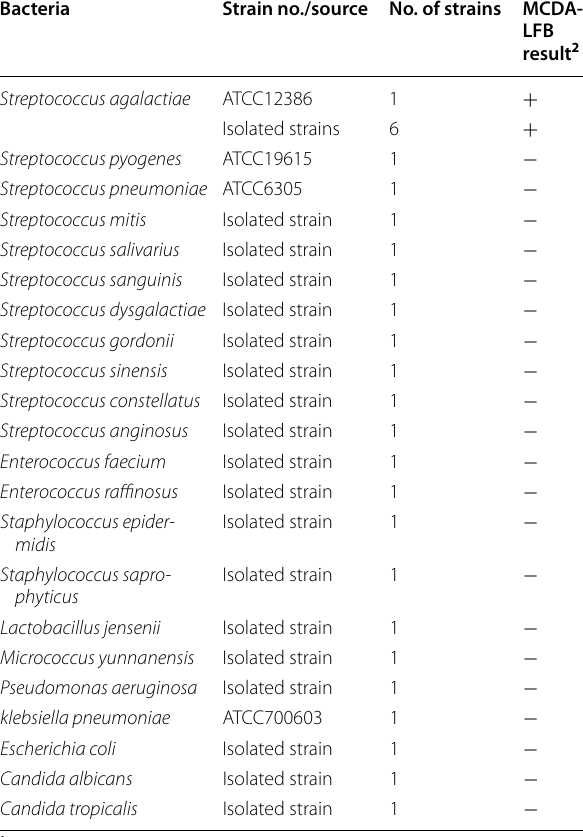
1 , positive; , negative + − 2 THH, Taihe Hospital; Sa, Streptococcus agalactiae